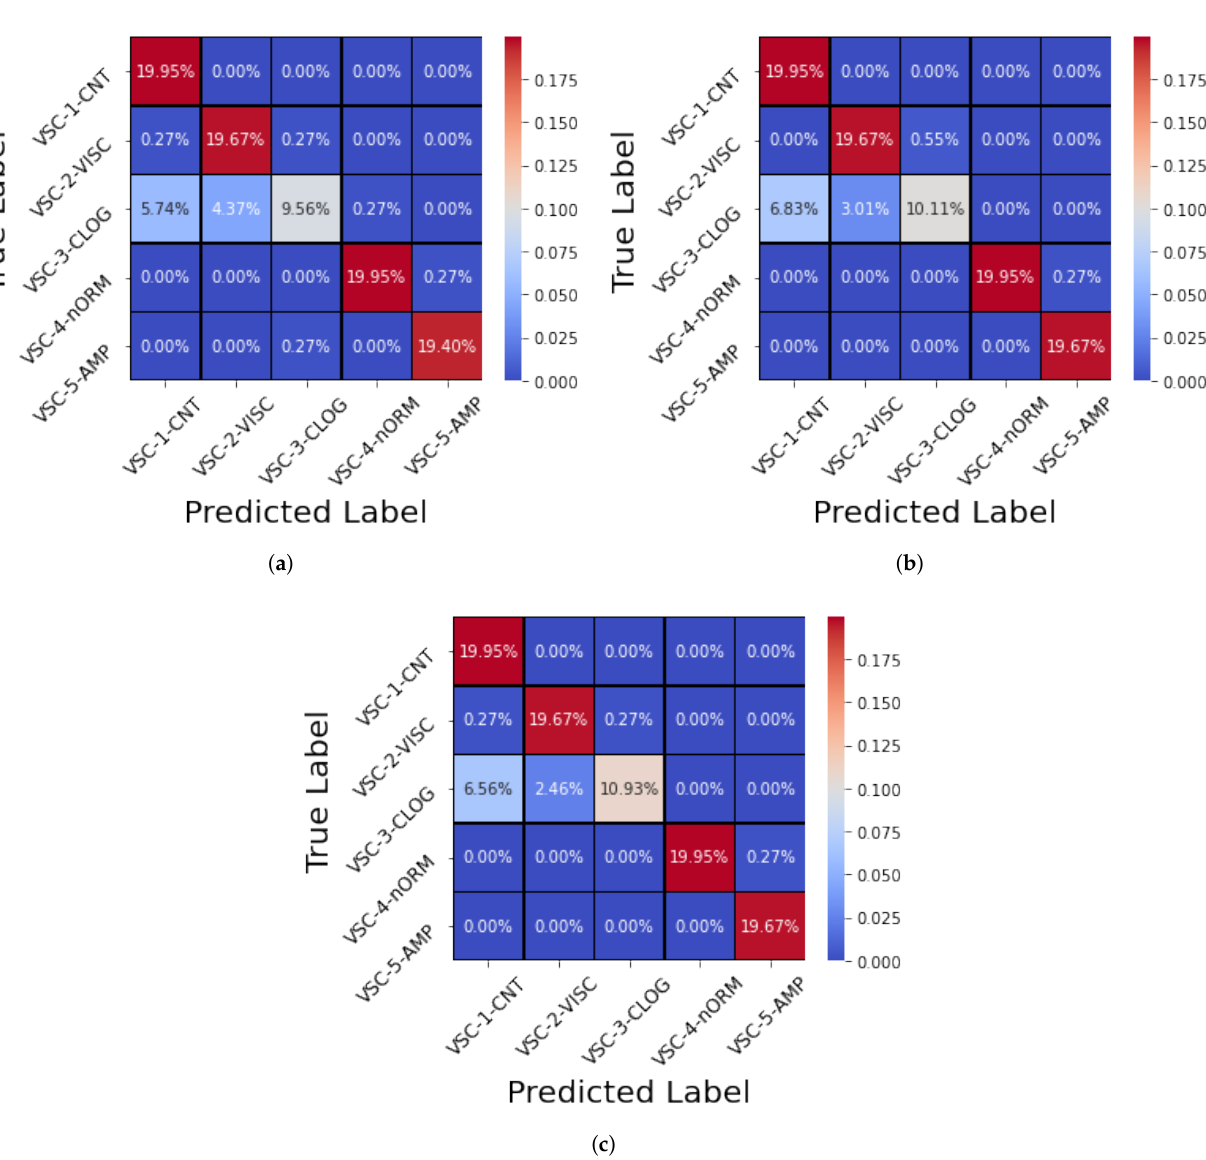
Figure 5. Confusion matrices on test samples from ( a ) DNN model ( b ) CNN model, and ( c ) D-dCNN